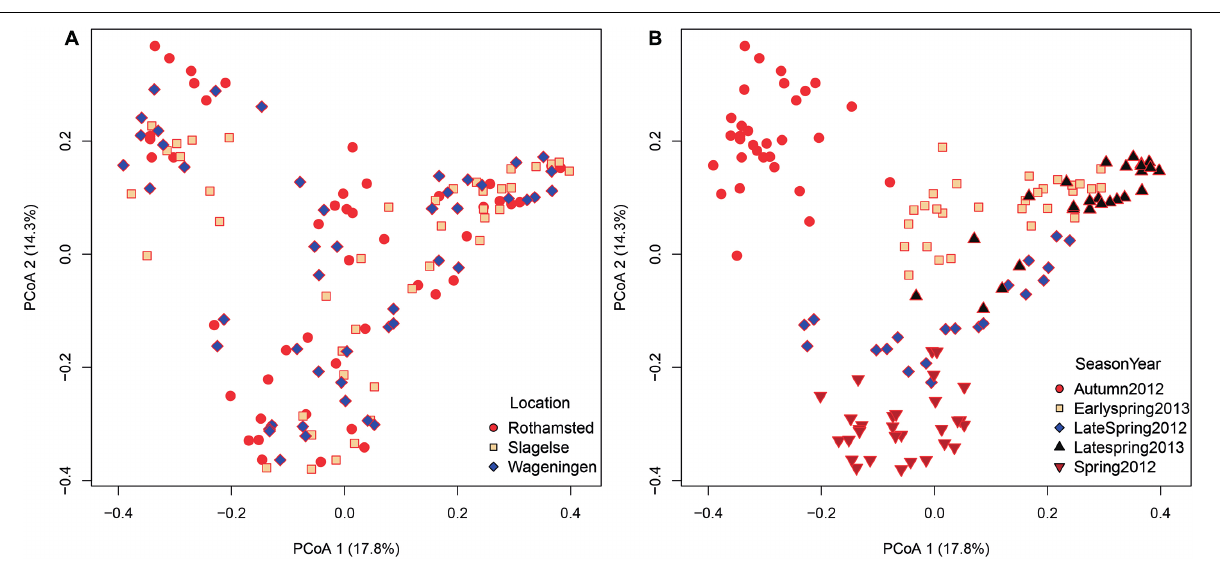
FIGURE 4 | Bray–Curtis matrices visualized using principal coordinates analysis (PCoA) (axes 1, 2, and 3) showing (A) distribution of samples according to location (Rothamsted, Slagelse, and Wageningen) in the dataset from rooftop samples, (B) distribution of samples according to season (early spring 2012, late spring 2012, autumn 2012, early spring 2013, late spring 2013) in the dataset from rooftop